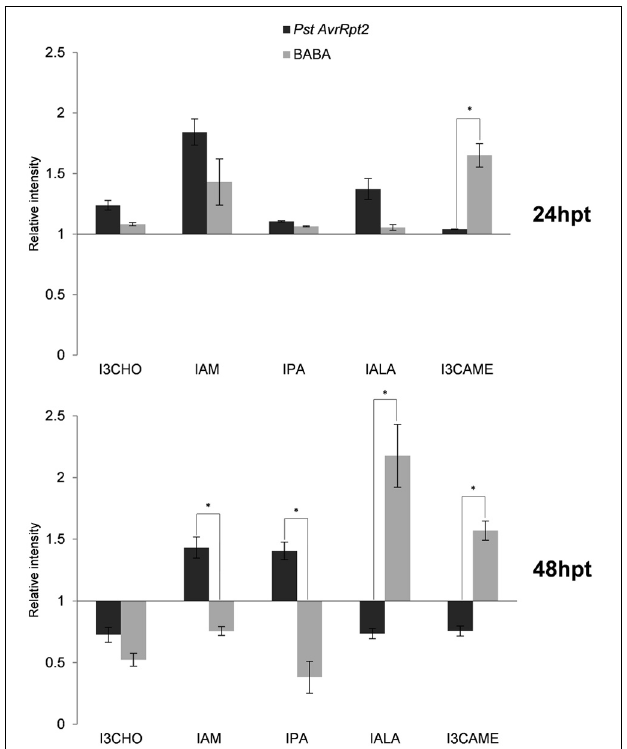
FIGURE 6 | Profile of indolic compounds during the priming phase. The experimental conditions and quantification of the levels were calculated as indicated in Figure 2 . Asterisks represent statistically significant differences (Wilcoxon Mann–Whitney test, p < 0 . 05, n = 6). Data represent average of three independent